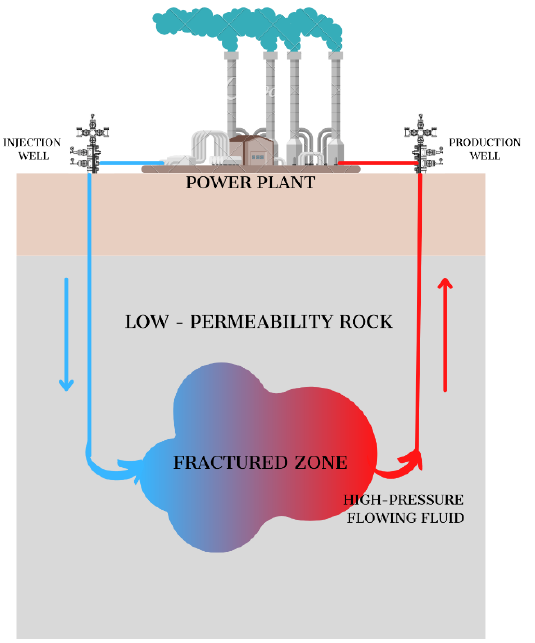
Figure 1. The concept of Enhanced Geothermal System technology (modified after [15,16]).